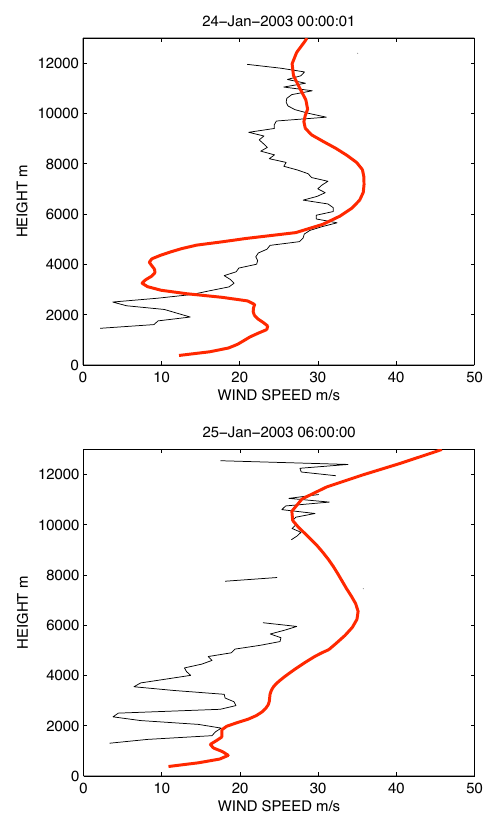
Fig. 10. Comparison of wind profiles between WRF (red) and ES- RAD (black). At 00:00UTC on 24 January and at 06:00UTC on 25